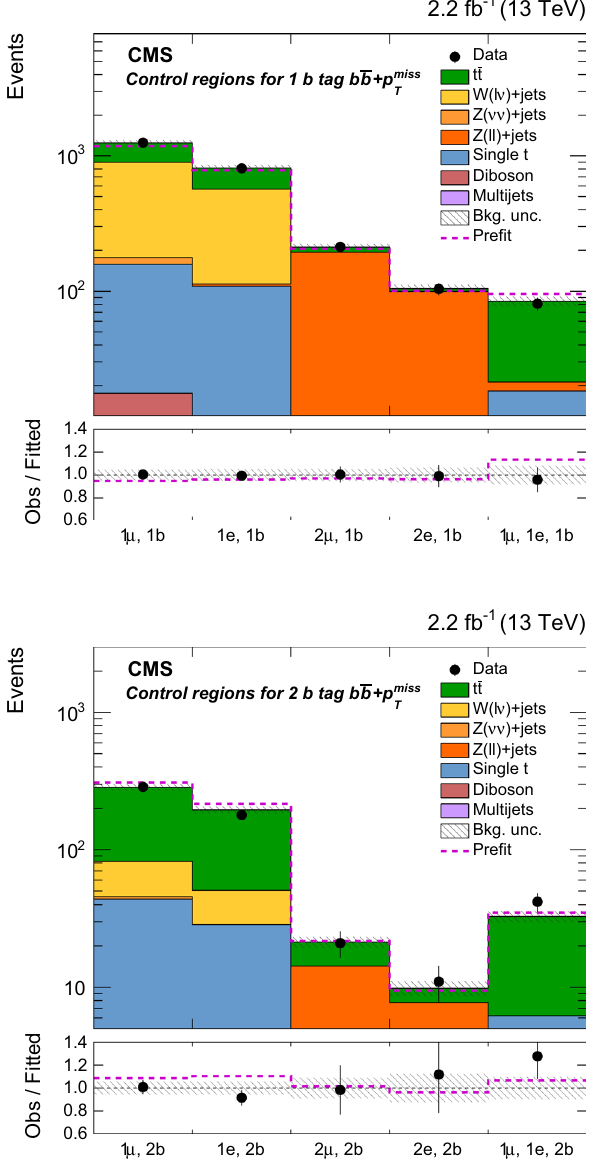
Fig. 6 Observed data, and prefit and fitted background-only event signal region yields in the control regions associated with the bb + p miss T with 1 b tag (upper) and with 2 b tags (lower). The 1 lepton, ≥ 1 b con- trol regions (bbA, bbB, bbF and bbG in Table 2) are used to constrain W + jets and tt backgrounds in the bb + p miss signal regions. The dilep- T tonic control regions (bbC-bbE, bbH-bbJ) are used to constrain Z + jets and tt backgrounds. The lower panels show the ratio of observed to fitted background yields. In both panels, the statistical uncertainties of the data are indicated as vertical error bars and the fit uncertainties as hatched bands. Prefit yields and the ratios of prefit to fitted background expectations are shown as dashed magenta histograms